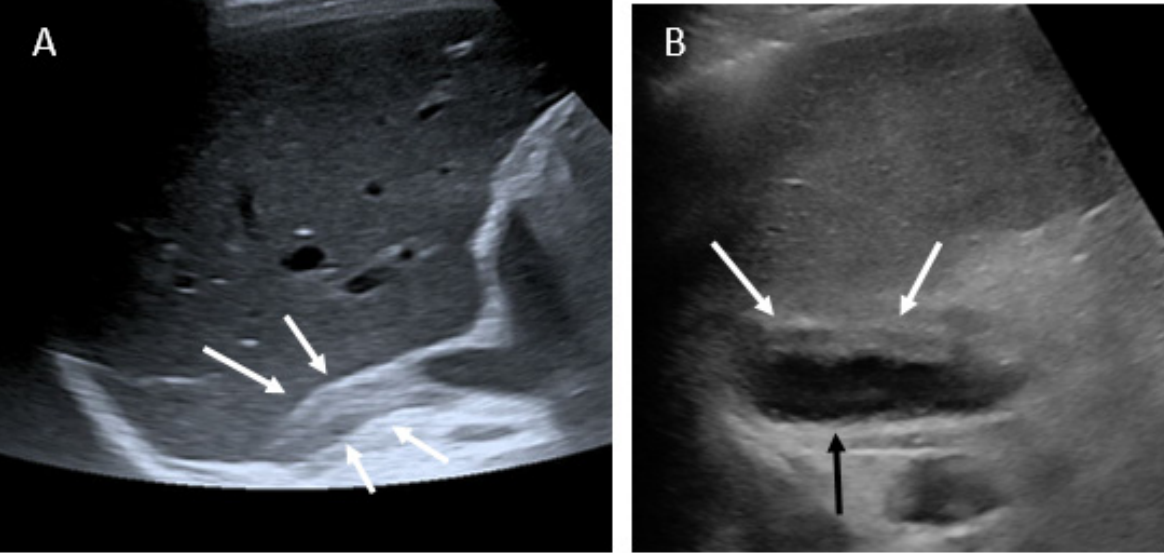
Figure 1. Ultrasound findings. ( A ): patient 1, enlarged right adrenal gland (white arrows); ( B ): patient 5, enlarged left adrenal gland (white arrows) associated with fluid collection (black arrow). Video S1: patient 5 US findings; showing fluid collection beside the swollen left adrenal